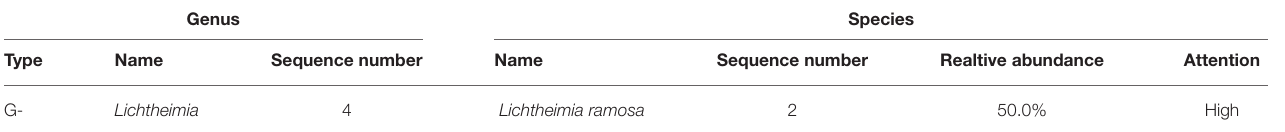
TABLE 1 | The results of